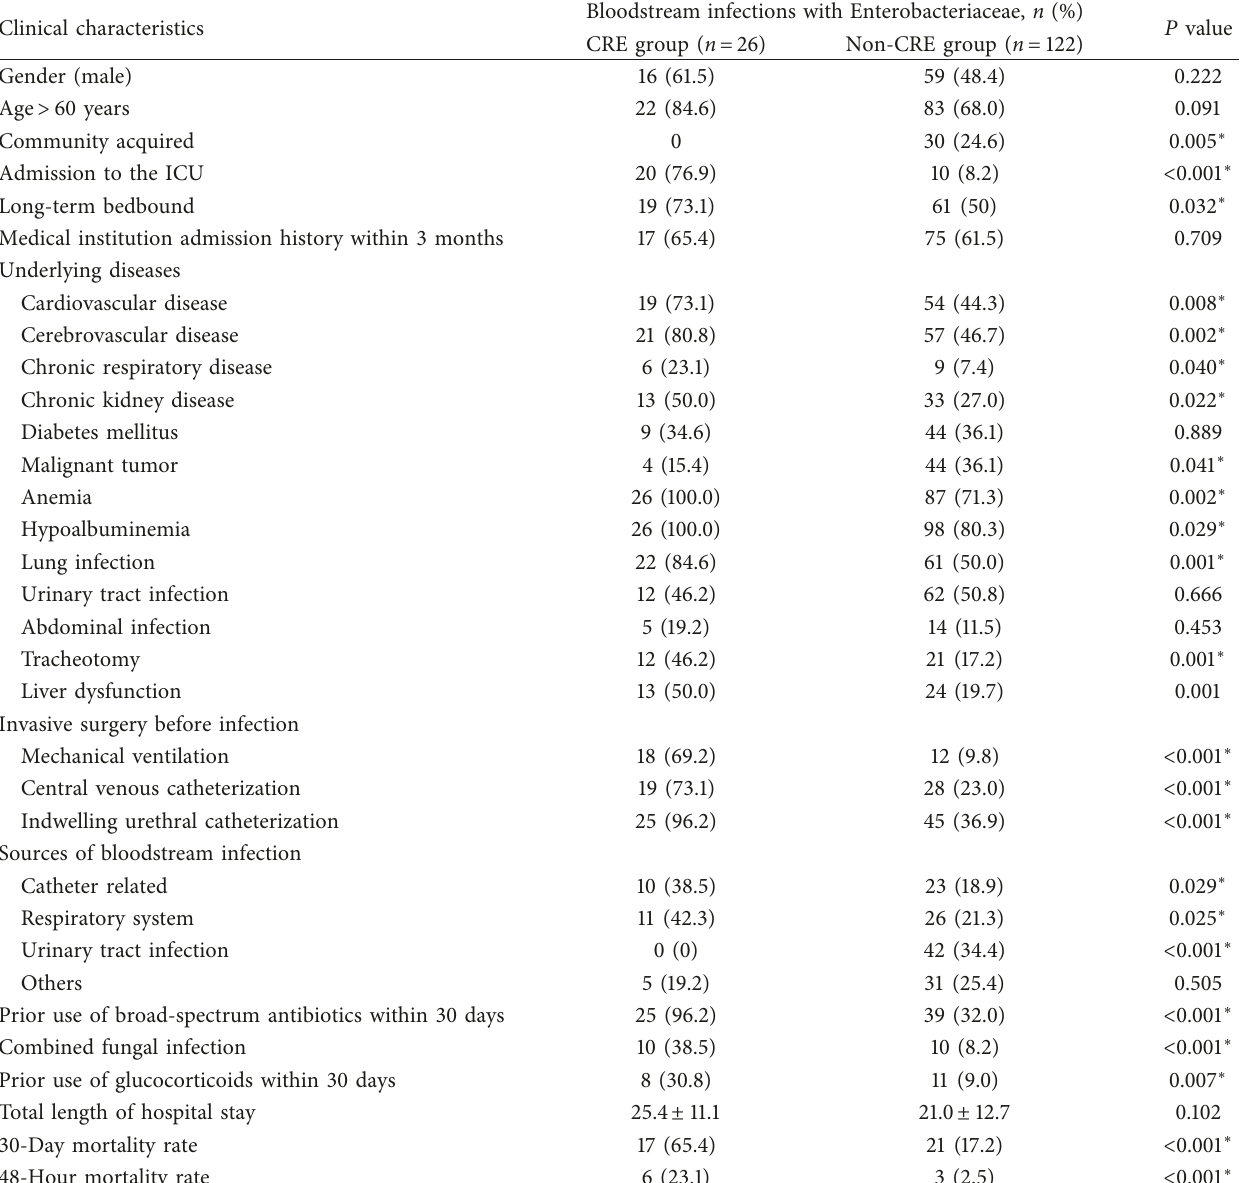
Table 1: Univariate analysis of the clinical characteristics of bloodstream infections caused by CRE and non-CRE. Clinical characteristics